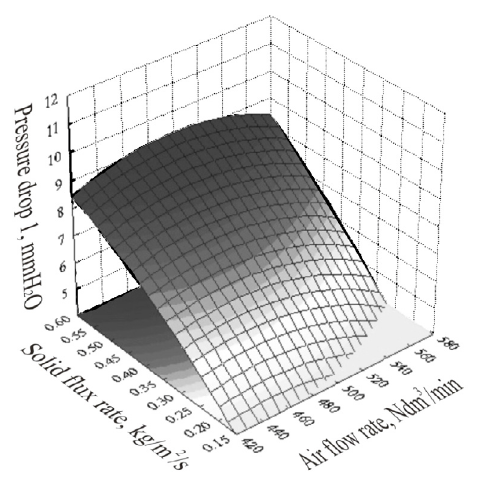
Fig. 9. Pressure drop at the bottom of the riser.